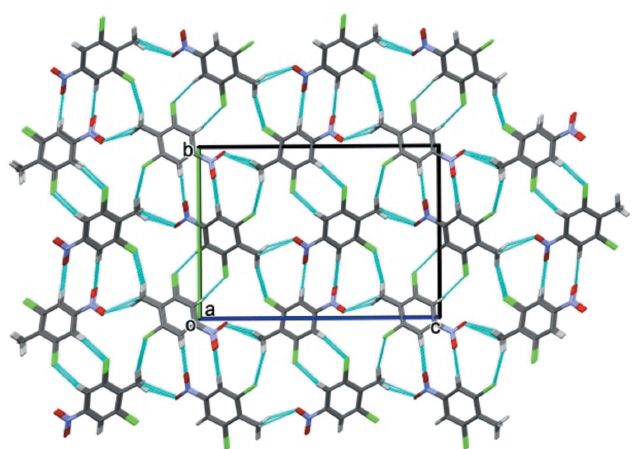
Figure 5 A view along the a axes of the crystal packing of 2,6-dichloro-4- nitrotoluene, DCNT.